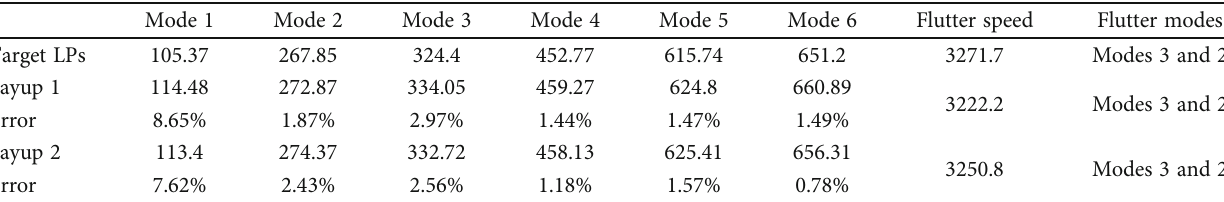
Table 2: Comparisons of frequency and fl utter